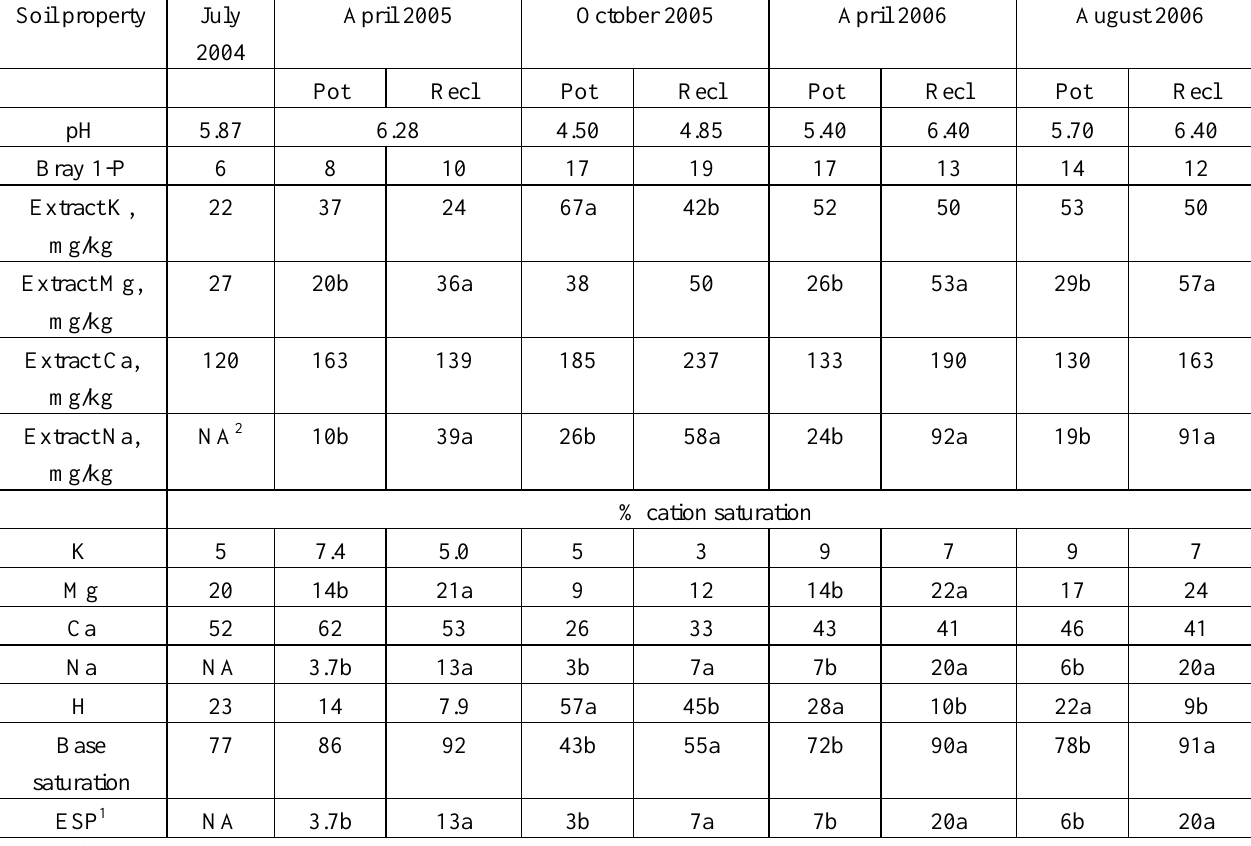
Table 2. Effects of potable (pot) and reclaimed (recl) irrigation treatments on soil properties. Soil property